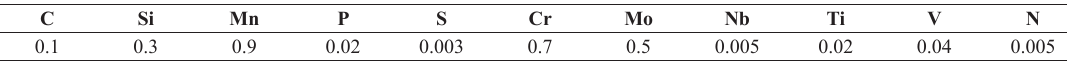
Table 1. Chemical composition of the studied steel